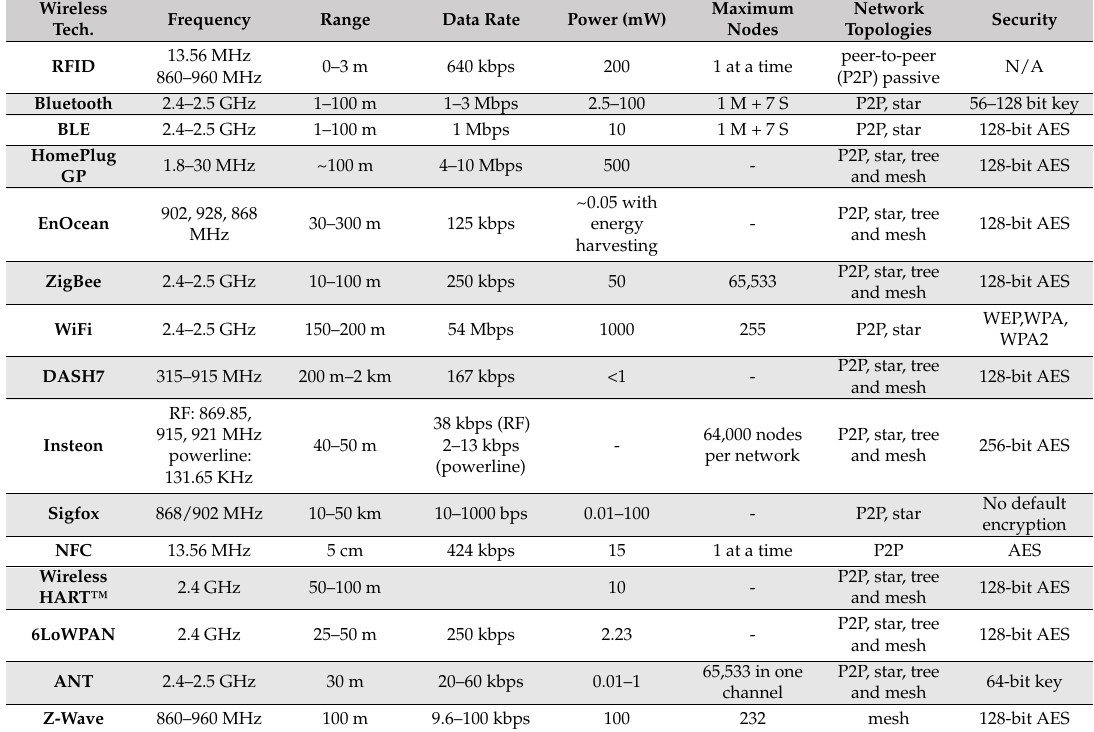
Table 2. Communication technologies for smart